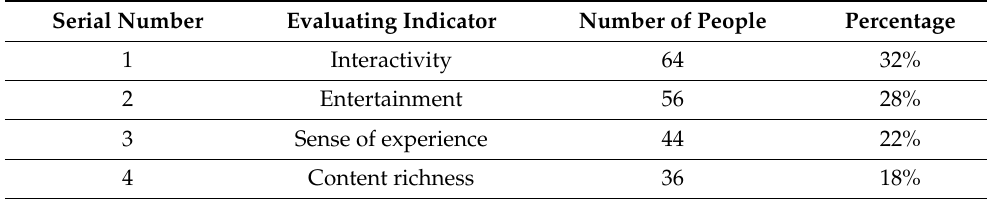
Table 2. Evaluation indicators of interactive design effect of digital